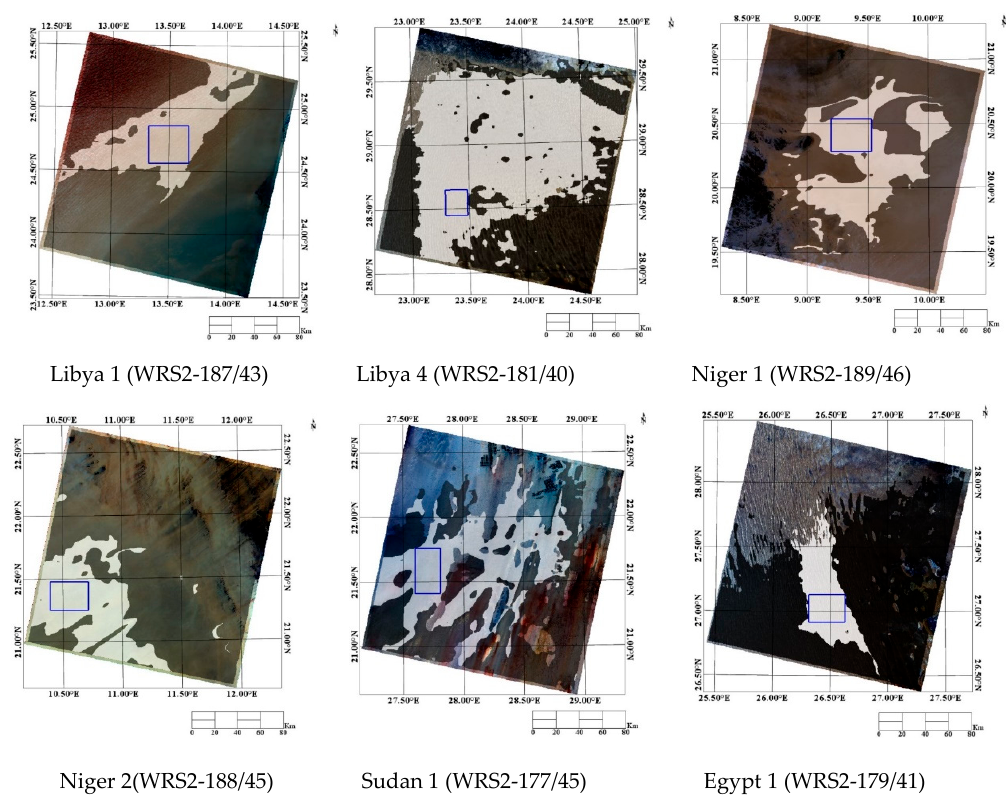
Figure 2. 3% Stable Optimal Regions (white masks) and Rectangular region of interests (ROIs) (blue rectangle) within SDSU IPLAB PICS (Niger 1, Niger 2, Libya 1, Libya 4, Egypt 1 and Sudan 1).